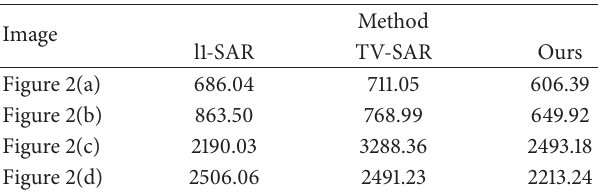
Table 3: Comparison of the time complexities (in